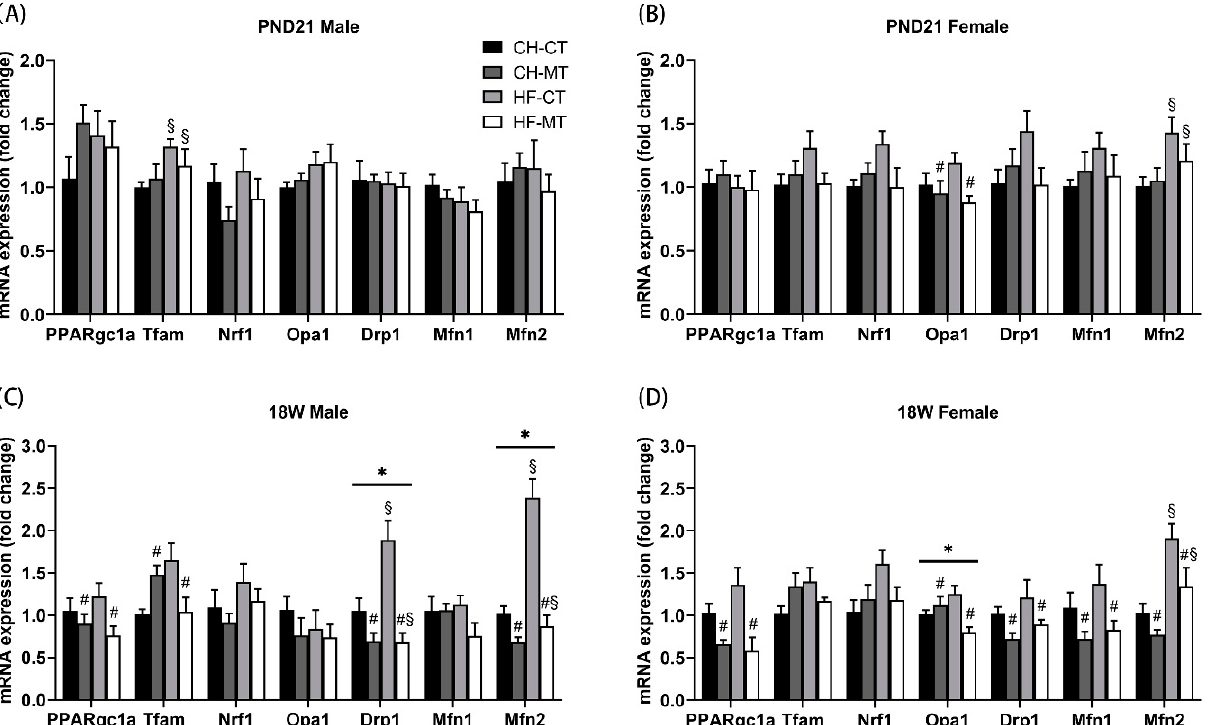
Figure 4. mRNA expression of mitochondrial biogenesis- and dynamics-related genes in skeletal muscle of offspring. mRNA expression of mitochondrial biogenesis- and dynamics-related genes in skeletal muscle was measured in PND21 males ( A ), PND21 females ( B ), 18W males ( C ) and 18W females ( D ). Data are expressed as mean ± S.E.M (n = 5–8 per group). Data were analyzed by two-way ANOVA, # main effect of maternal metformin, p < 0.05 versus control, § main effect of maternal HF diet, p < 0.05 versus maternal CHOW diet, * interaction effect of maternal HF diet and metformin, p < 0.05. Drp1, dynamic-related protein 1; Mfn, dynamin-related GTPase termed mitofusin; Nrf, nuclear respiratory factor; Opa1, Optic atrophy protein 1; Ppargc1a, peroxisome proliferator-activated receptor gamma coactivator 1-alpha; Tfam, mitochondrial transcription factor A.